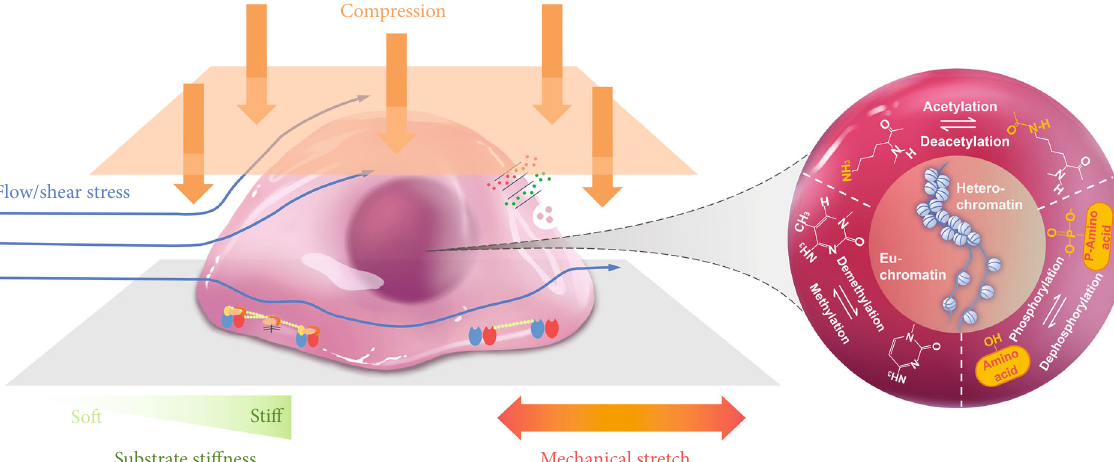
Figure 1: Mechanical cues regulate histone modi fi cations to modulate cell fate. Various mechanical stimuli, including substrate sti ff ness, mechanical stretch, topological substrate, shear stress, compression, and squeezing, modulate histone modi fi cations, which regulate chromatin reorganization and cell